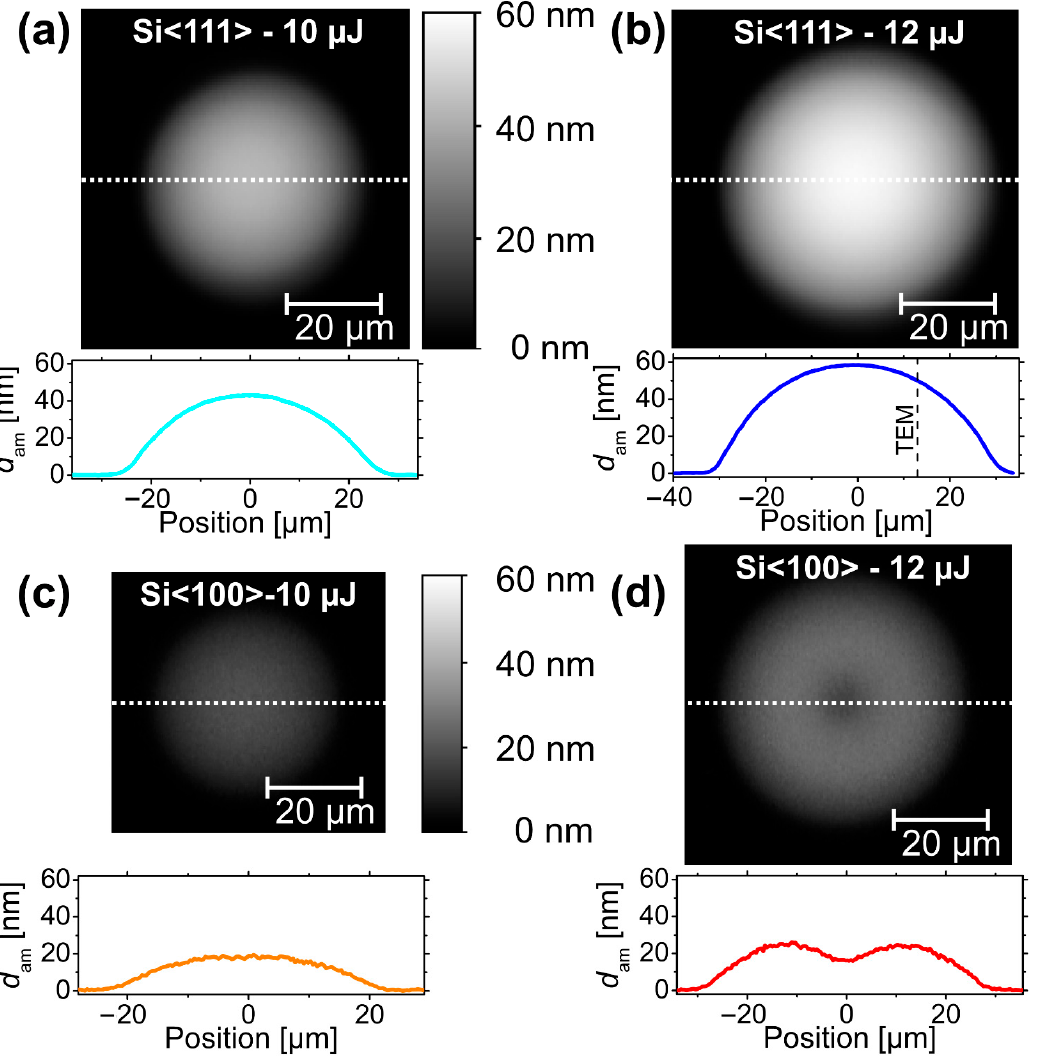
Figure 4. Maps of the amorphous silicon layer thickness ( d am ) as determined by spectroscopic imaging ellipsometry (SIE) at four different fs-laser-irradiated spots on Si<111> ( a , b ) and Si<100> ( c , d ) at two laser pulse energies of 10 µJ ( φ 0 = 0.20 J/cm 2 ; ( a , c )) or 12 µJ ( φ 0 = 0.24 J/cm 2 ; ( b , d )). The maps have a common scale bar provided in ( a , c ) and are encoded by a joint linear grayscale that indicates the thickness. Below each map, a corresponding horizontal cross-section (location indicated by a white dashed line) of the a-Si layer thickness is drawn. The vertical black dashed line in ( b ) indicates the position of the TEM/STEM measurements as marked by the red square in Figure 1. The simultaneous fit of the amorphous silica (SiO 2 ) cover layer yielded an almost constant thickness of d ox ~3 nm to 5 nm inside and ~2 nm to 3 nm outside the laser-amor- phized regions for each of the examined SIE maps. This is exemplified in Figure 5 visual- izing the modeled spatial variation of the silicon oxide layer thickness for spots on Si<111> irradiated by single pulses of E p = 12 µJ / φ 0 = 0.24 J/cm 2 (a, left) and E p = 15 µJ / φ 0 = 0.30 J/cm 2 (b, right).